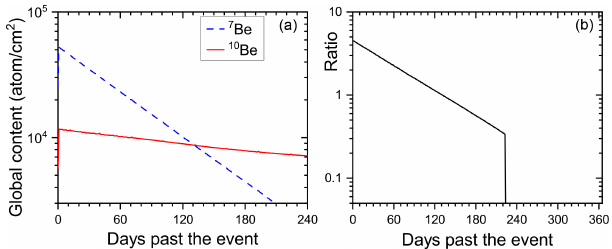
Figure 4. Computed global mean columnar content of two beryl- lium isotopes, 7 Be and 10 Be, produced by SPE on 20 January 2005 (day zero) as a function of time. The nearly exponential decay of the concentration ( τ = 550 ± 100d and 72 ± 2d for 10 Be and 7 Be, respectively) includes both decay and sink (deposition) of the iso-